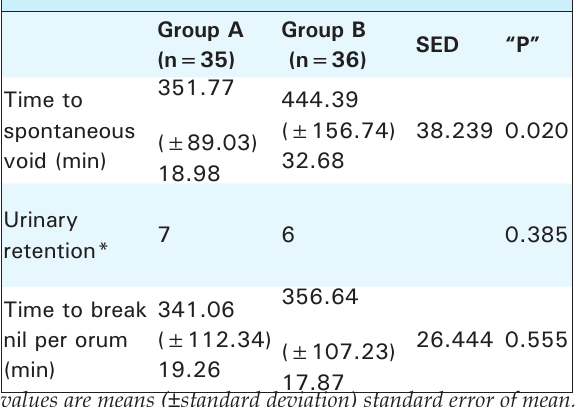
Table 7. Postoperative recovery